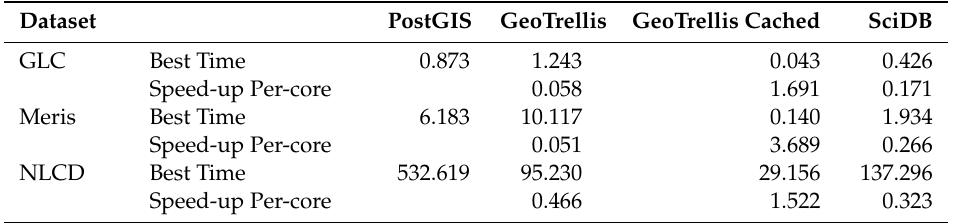
Table 6. Reclassification best time and speed-up for all raster